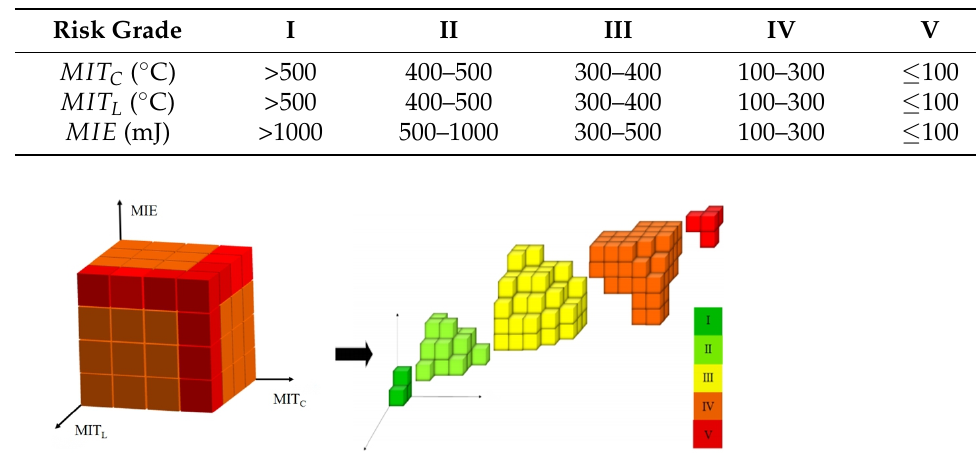
Table 1. Dust’s MIT C , MIT L , and MIE risk classifications.